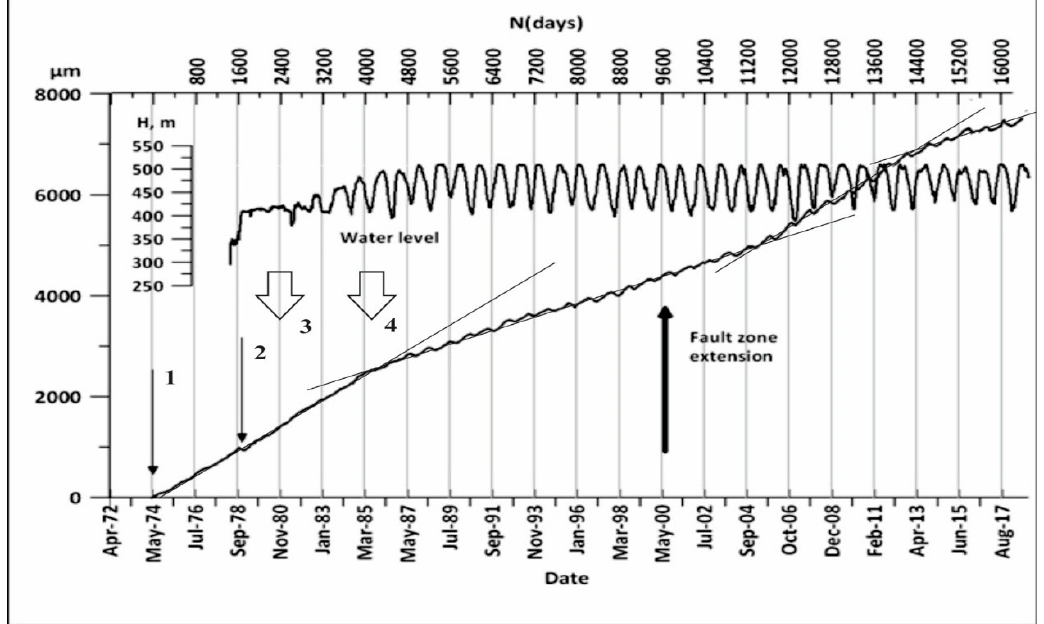
Figure 3. WL in the Enguri lake from 1978 (upper curve) to 2017 and the data on the extension– compaction of the branch of a large Ingirishi fault, crossing the foundation of the dam from 1974 to 2017 (lower curve). Arrow 1 corresponds to the start (in 1974) of strainmeter monitoring four years before impounding, arrow 2 corresponds to the episode of the fault compaction by approximately 90 μ m due to WL rising fast by 100 m in 1978, arrows 3 and 4 show the moments of transitions in the nonlinear dynamics pattern of local seismicity (see Section 4). The upper horizontal axis shows the number of days after the start of strainmeter monitoring. Dashed straight lines mark periods of the fault’s constant extension component